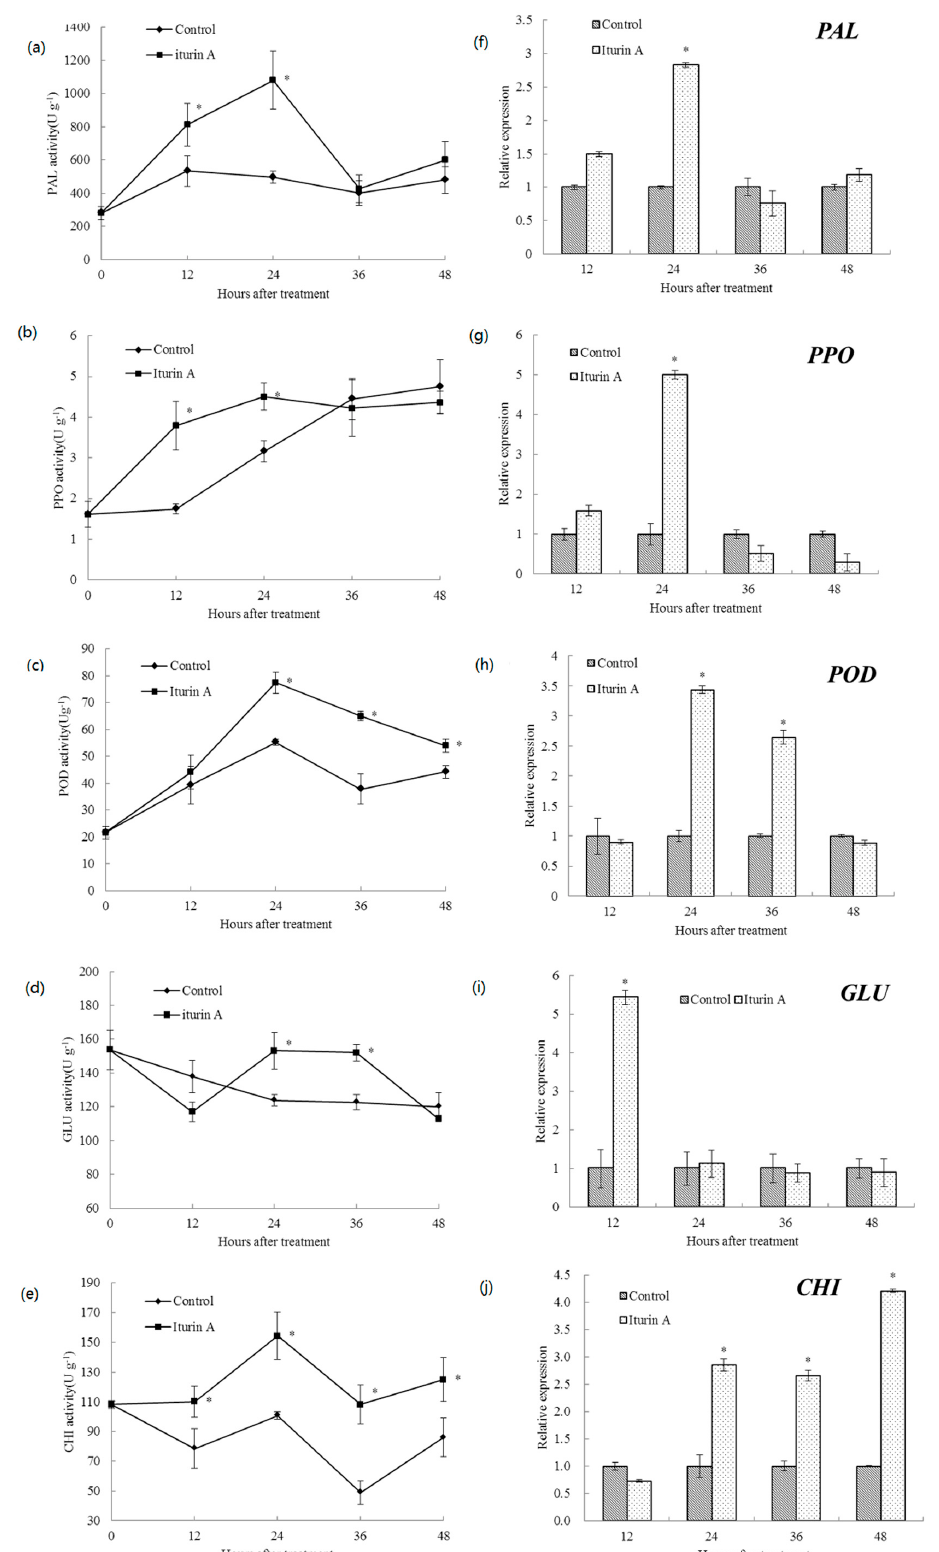
Figure 3. Activities of PAL ( a ), PPO ( b ), POD ( c ), GLU ( d ), and CHI ( e ) and relative expression levels of PAL ( f ), PPO ( g ), POD ( h ), GLU ( i ), and CHI ( j ) in cherry tomato fruit after treatment with sterile distilled water (control) and 512 µ g/mL of iturin A. The vertical bar represents the standard error for three replicate samples and the asterisks (*) represent significant differences between the iturin A treatment and the control by the unpaired t -test ( p <